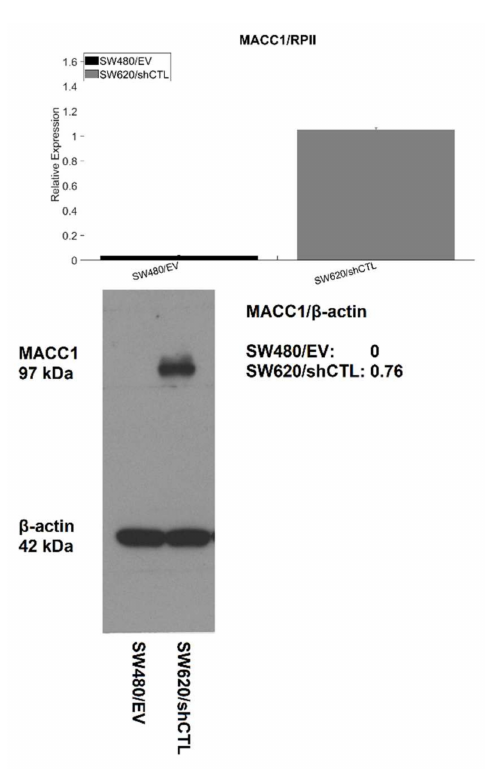
Figure A2. mRNA expression of MACC1 (top) and representative Western blot (bottom) for SW480/EV and SW620/shCTL, including densiometric analysis.